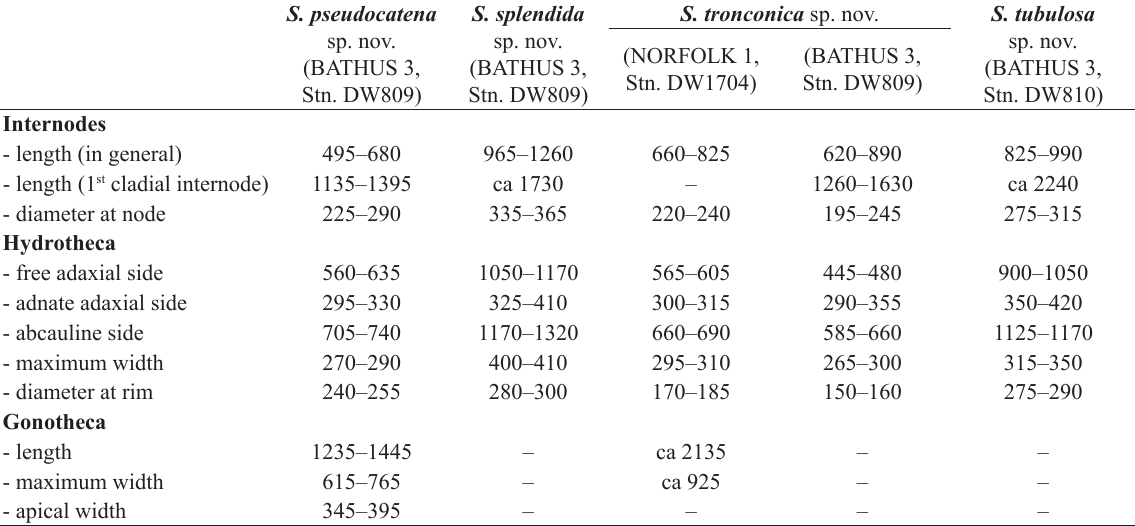
Table 6. Measurements (in µm) of four new species of Sertularella discussed